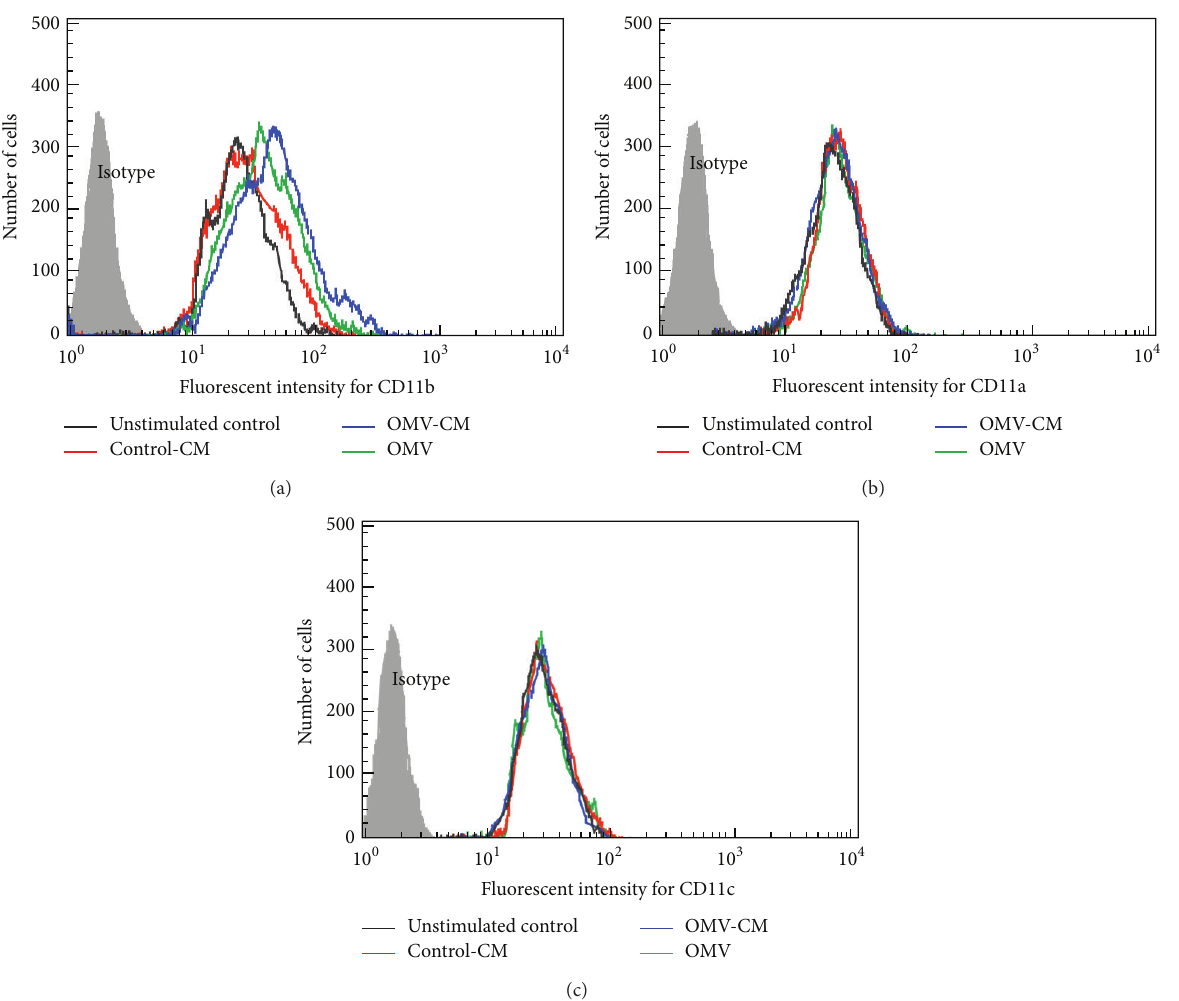
Figure 5: Increased CD11b expression in eosinophils stimulated with H. pylori OMVs or OMV-CM. Freshly isolated human eosinophils were stimulated with OMVs (200 𝜇 g/mL), OMV-CM (50% v/v), or control-CM (50% v/v) for 24 h. Cells were stained with mAb against CD11b (a), CD11a (b), or CD11c (c) and then analyzed using flow cytometry. Results are representative of more than five independent experiments.